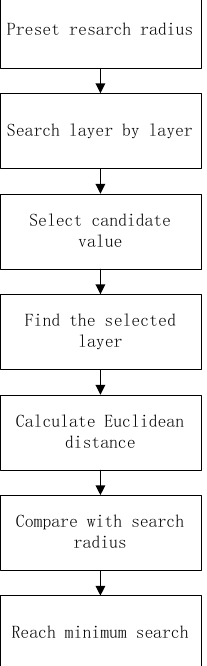
Figure 3. Breadth-first search algorithm flow chart.